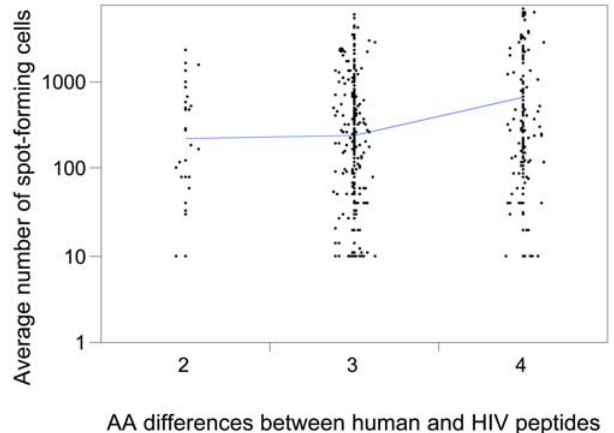
Figure 2. Magnitude of the ELISpot responses elicited by HIV-1 B Nef peptides as a function of their similarity to human peptides. The vertical axis corresponds to the mean number of spot-forming cells counted in ELISpot assays. The horizontal axis corresponds to Nef peptides that have 2, 3 or 4 differences with their closest human